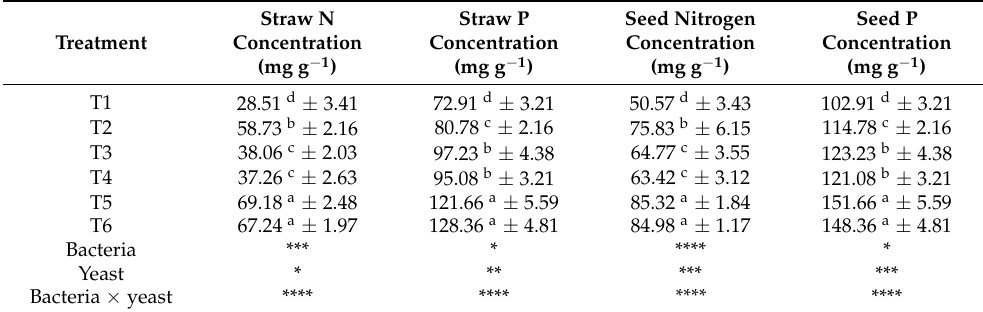
Table 3. Differences in soybean straw N, Straw P, seed N concentration, and seed P concentration across treatments at R8 physiological stage, and rhizosphere available P after the experiment.